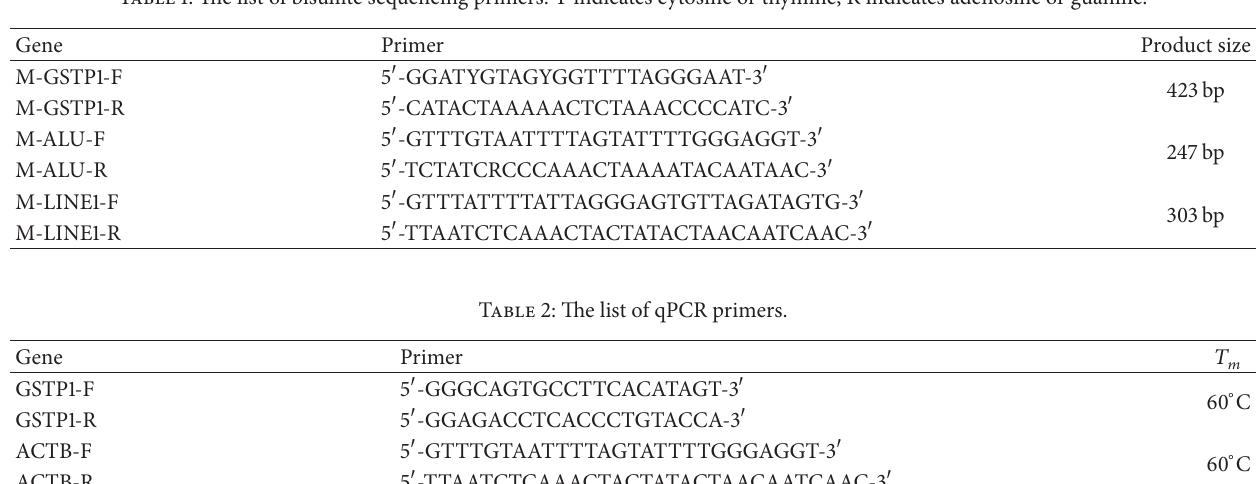
Table 1: The list of bisulfite sequencing primers. Y indicates cytosine or thymine; R indicates adenosine or guanine.